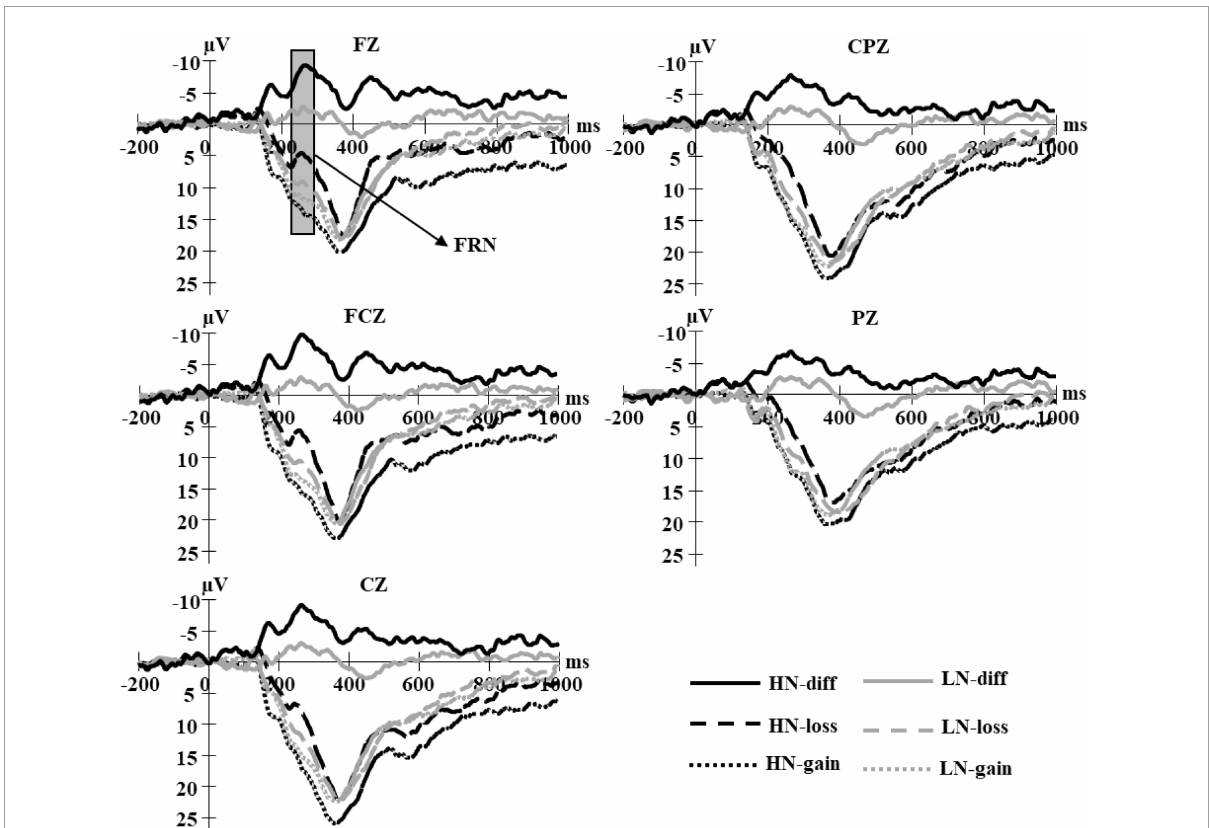
FIGURE3 Grand average waveform for loss and gain feedback, separated by high narcissism (HN) and low narcissism (LN).